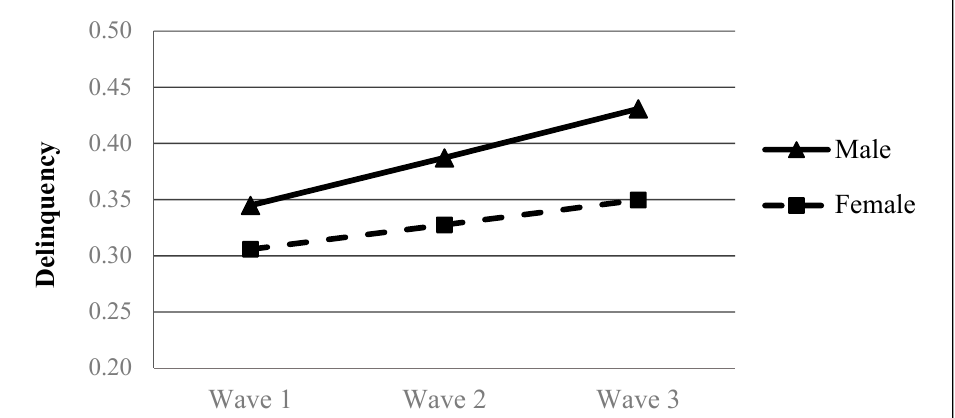
Figure 1. Growth trajectories of adolescent delinquency as a function of gender. The figures were plotted based on Model 3 shown in Table 5.